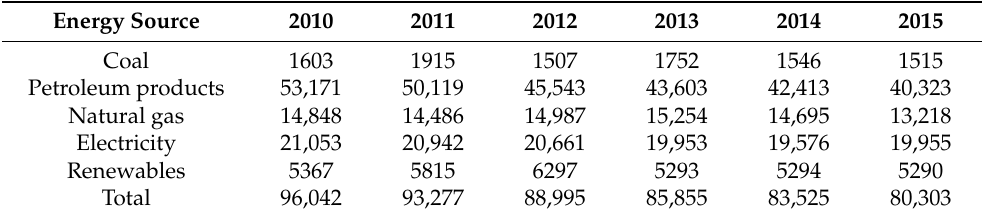
Table 1. Annual evolution of energy consumption in Spain (Unit: thousands of tonnes of oil equivalent) Source: IDAE